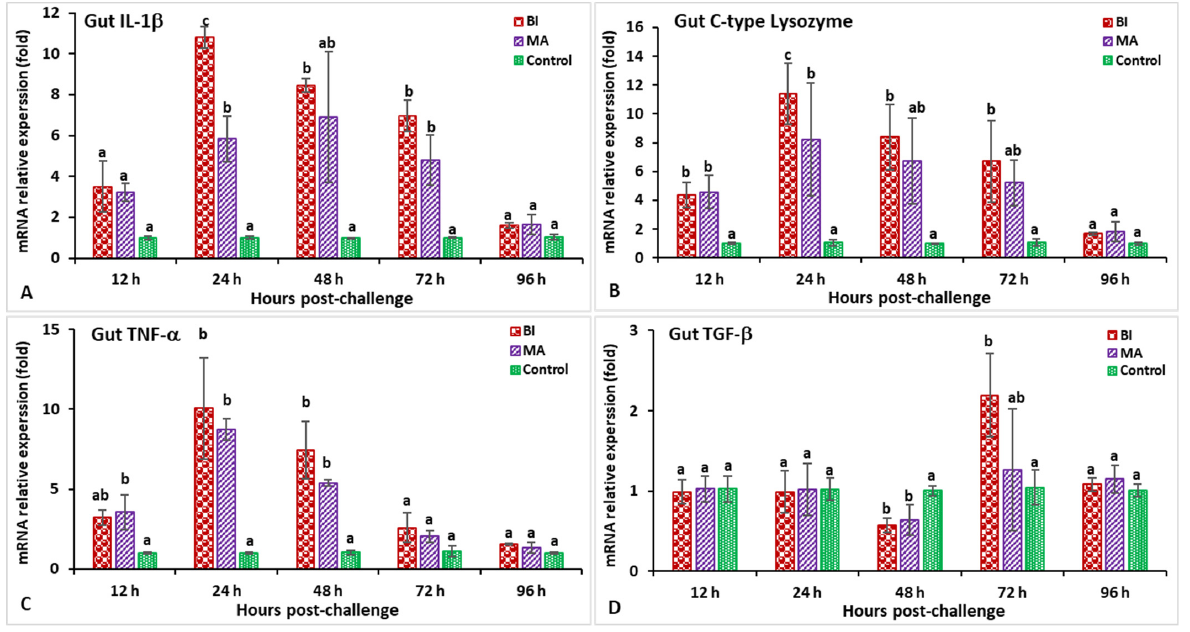
Figure 13. The gene expression of IL-1 β ( A ), C-type lysozyme ( B ), TNF- α ( C ), and TGF- β ( D ) in the hindgut tissue of orally vaccinated fish after being challenged by Aeromonas hydrophila (mean ± SE, n = 3). Dissimilar letters denote significant differences ( p < 0.05).